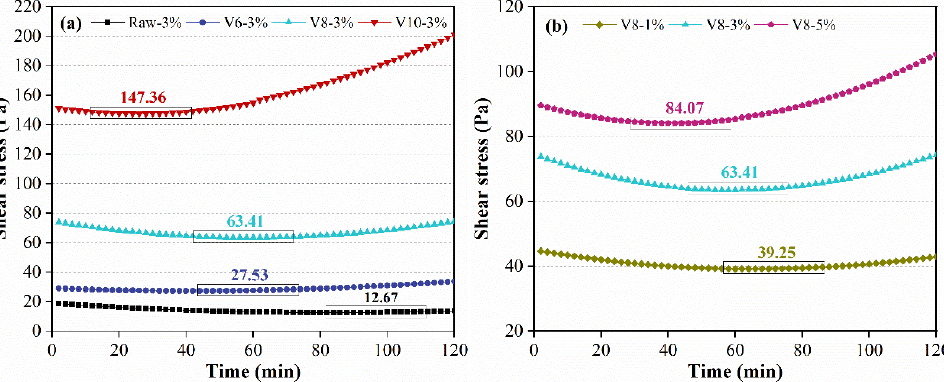
Figure 5. Shear stress of BFS-SS-based pastes at a constant shear rate of 50 s −1 : effect of BFS fineness ( a ) and effect of NC dosage ( b ). ( a ) and effect of NC dosage ( b